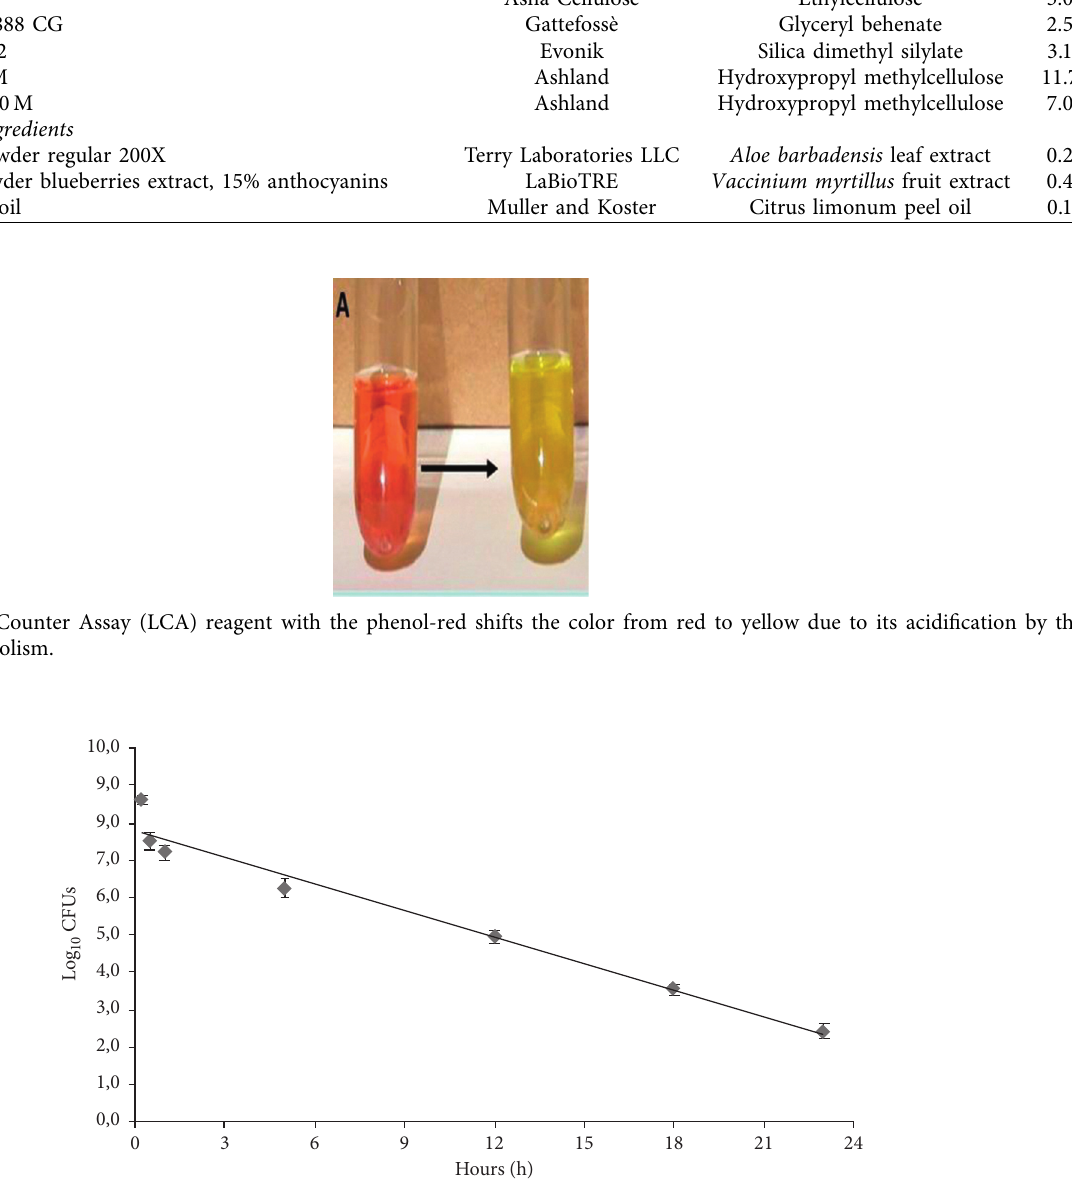
Figure 2: Correlation line between the number of Lactobacillus spp. and the time of color change of the Lacto-Counter Assay (LCA) reagent.